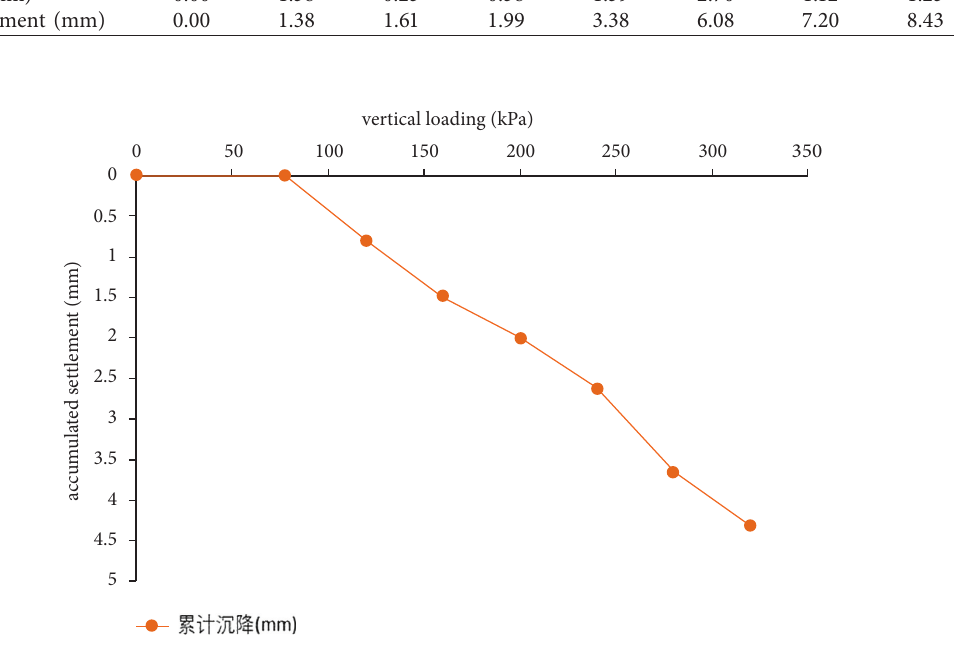
Figure 5: Pictures of test loading